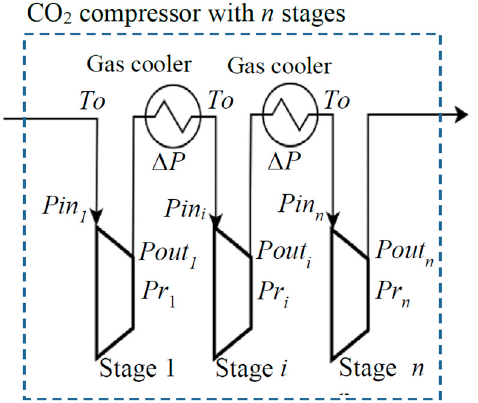
Figure 1. Illustration of a CO 2 compressor design with n stages.